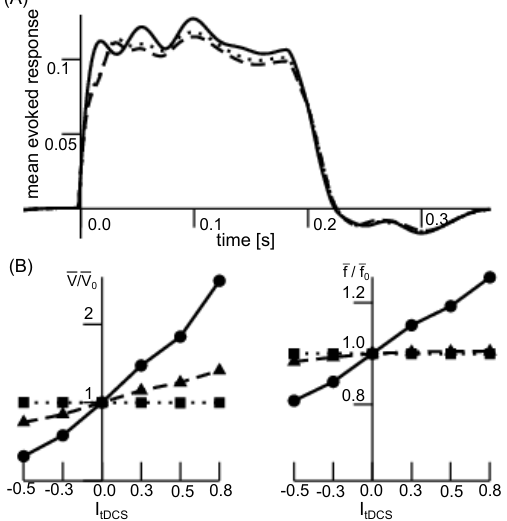
Figure 2. tDCS-induced excitability. ( A ) The evoked potential time course is shown for tDCS input current I tDCS = 0.0 (dashed), I tDCS = 0.3 (dotted) and I tDCS = 0.8 (solid). The larger I tDCS , the larger is the response magnitude during transient stimulation (up to ∼ 200 ms). After stimulation, the system response is almost identical for all input currents. ( B ) The relative baseline resting potential (left panel) and firing rate (right panel) in the precursor time interval 50 ms before stimulation input. The value ¯ V 0 ( ¯ f 0 ) is the baseline resting potential (resting firing rate) for absent input currents. The lines denote the summed up relative resting activity in the cortical GIG neurons (solid line), in the excitatory relay cells (dashed line) and the reticular cells (dotted line). We observe an increase of the resting membrane potential (left) for I tDCS > 0 (a-tDCS) and a decrease for I tDCS < 0 (c-tDCS) in cortical and relay cells, whereas no impact on reticular cells is found. Conversely, the resting firing rate is poorly modulated by the tDCS